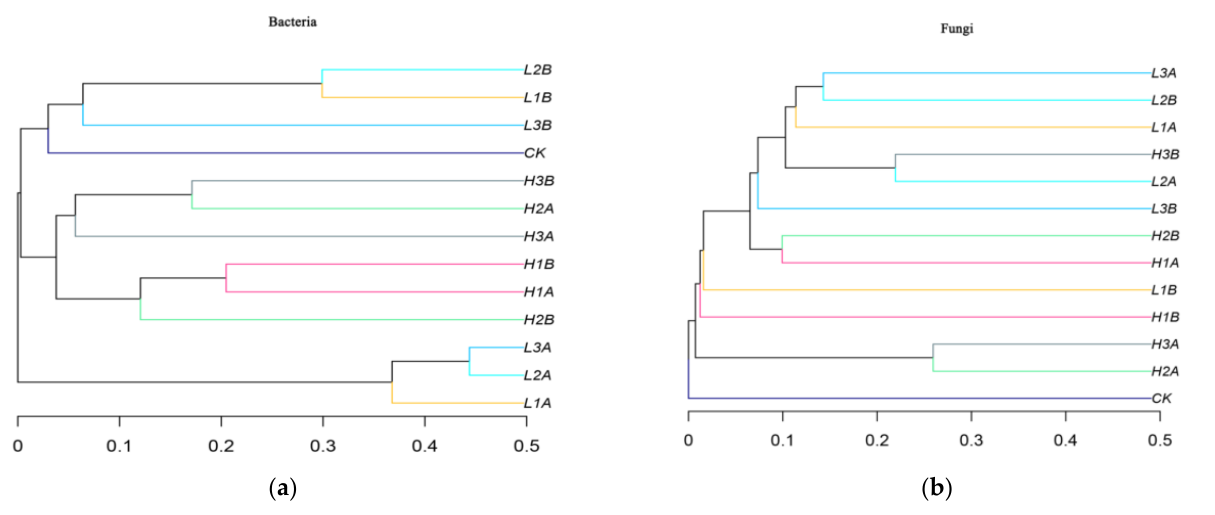
Figure 3. OTU cluster tree of bacteria and fungi. ( a ) Bacterial Level. ( b ) Fungi Level.